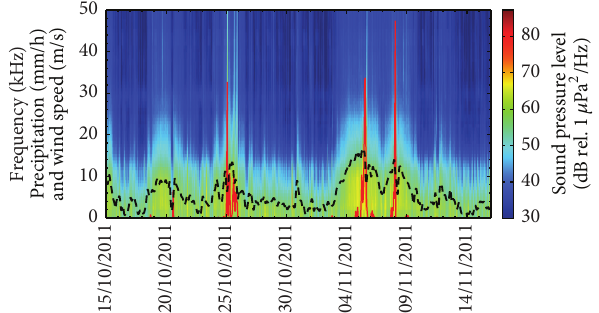
Figure 5: Sound pressure level spectra acquired by PAL between October 15 and November 15, 2011 and, superimposed, rainfall rates (solid line) and wind speed measurements (dashed line) collected by the rain gauge and the sonic anemometer on board the buoy, respectively. Three major stormy events passed over the buoy position on October 25, November 5, and November 7-8,